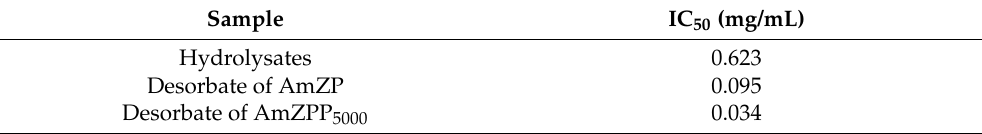
Table 5. Selective screening of ACE inhibitory peptides from hydrolysates by AmZP and AmZPP 5000